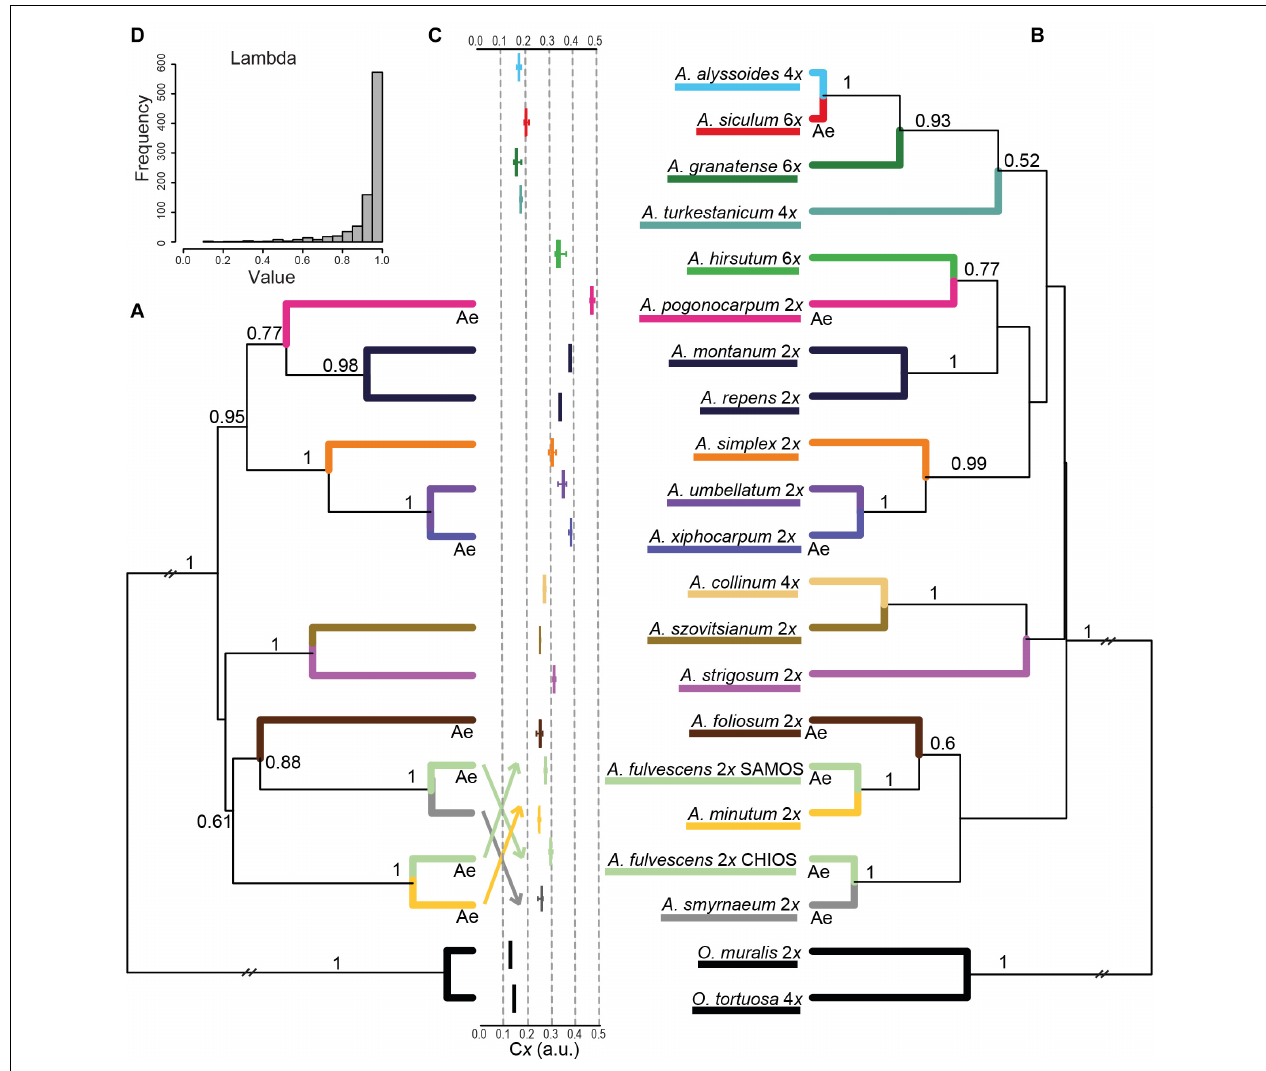
FIGURE 7 | Results of the species tree inference in the studied Alyssum species. The maximum clade credibility species trees, which were obtained from the coalescent analysis in BEAST are shown, based on (A) cpDNA, ITS, and DET1 datasets for diploids, and (B) cpDNA and ITS datasets for both diploids and polyploids (excluding the tetraploid A. simulans , see section “Materials and Methods”). Posterior probability values ≥ 0.5 are indicated above the branches. Ploidy levels are shown next to the species names. ‘Ae’ below branches indicates the placements of Aegean subendemics referred to in the text. (C) Boxplots depicting the relative monoploid genome size (C x ) values measured for the studied species. See Table 2 and Supplementary Table 1 for the precise population- and species-level C x values. (D) Posterior distribution of the tree transformation statistic λ (Pagel, 1999), computed by MCMC analyses in BayesTraits, quantifying the phylogenetic signal in genome size